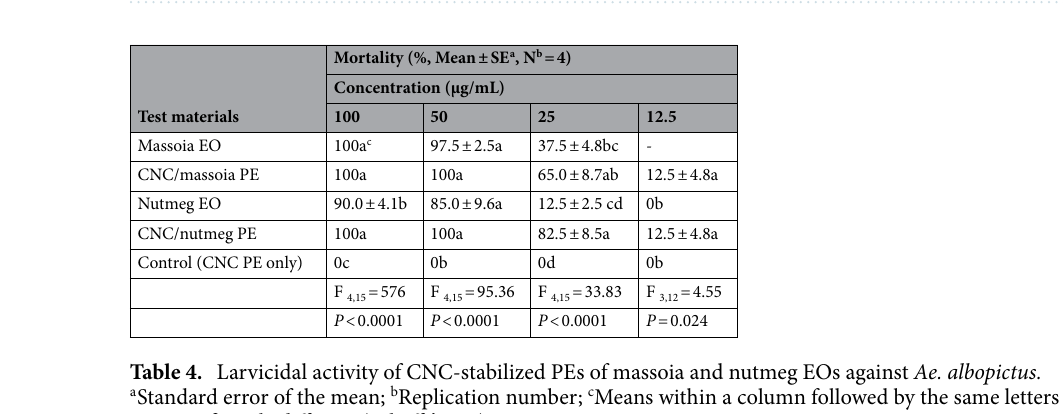
Figure 5. Confocal microscopic images of ( A ) CNC/massoia PEs (CNC 270 mg/mL massoia ) and ( B ) CNC/ nutmeg PEs (CNC 180 mg/mL nutmeg ).